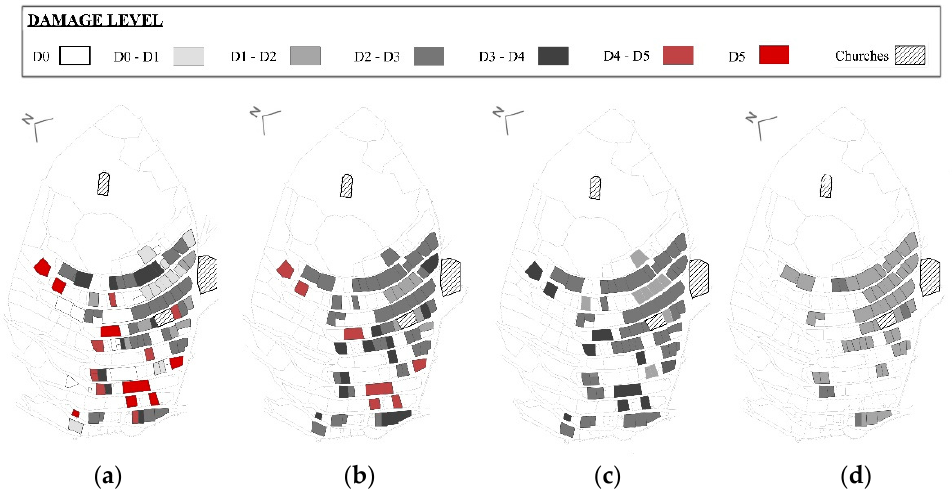
Figure 15. Comparison between the real damage detected in the case study ( a ) and the theoretical damage scenarios evaluated through ( b ) the GDNT, ( c ) the Vicente and ( d ) the Formisano method for each SU.